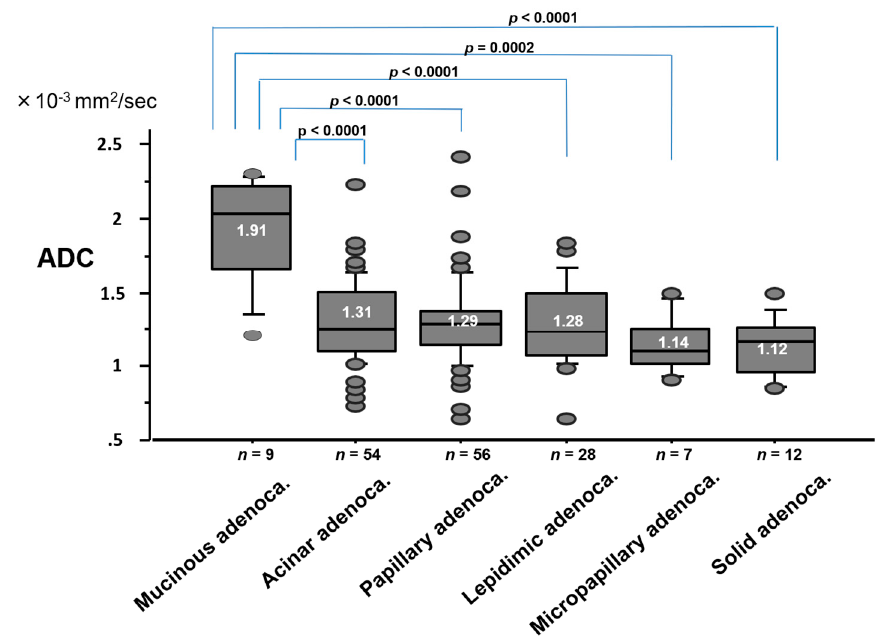
Figure 6. ADC value by pathologic subtype of adenocarcinoma.